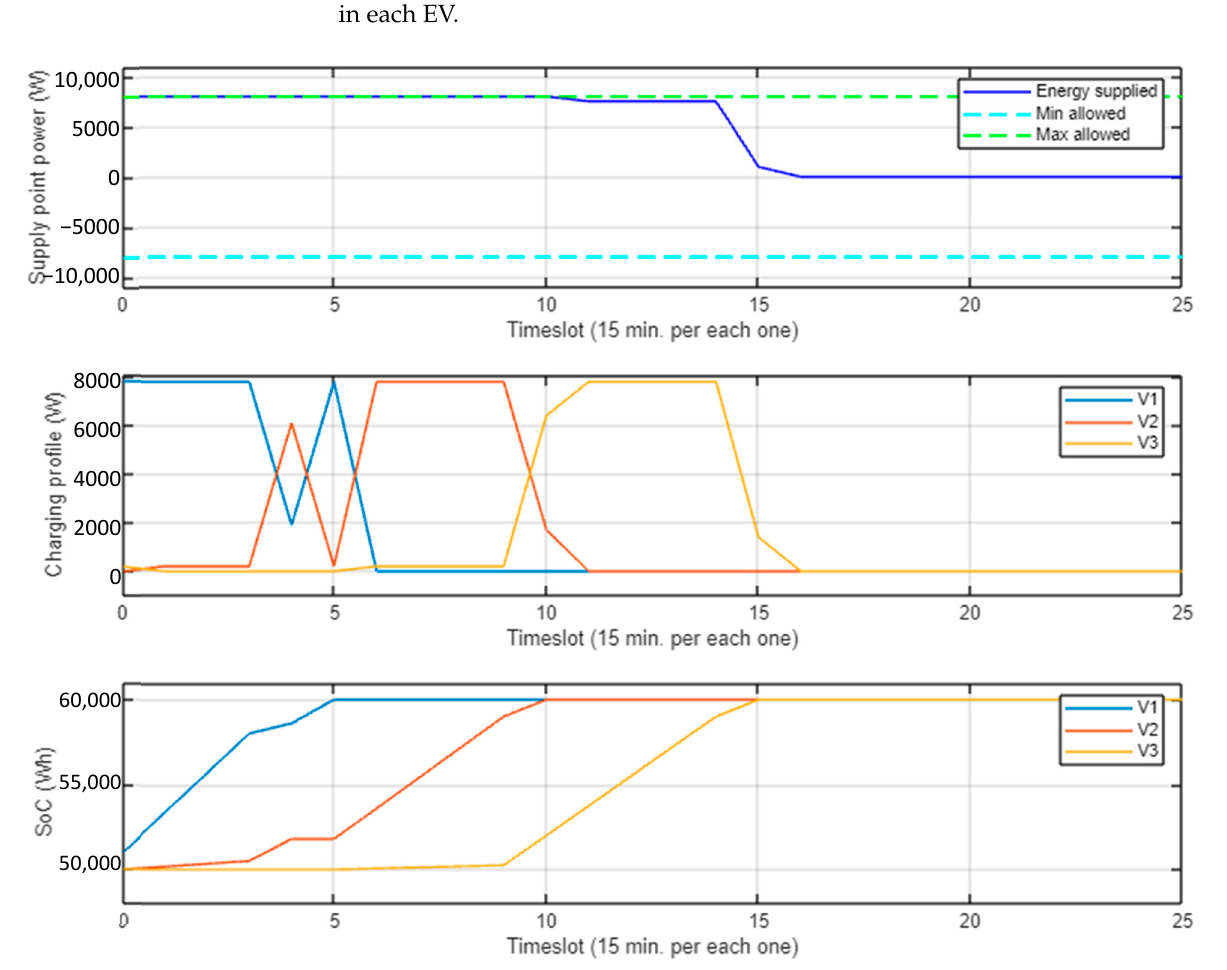
Figure 11. SCT output for considering restrictions ordered by grid operators. Horizontal axis represents the time span (corresponding to 15